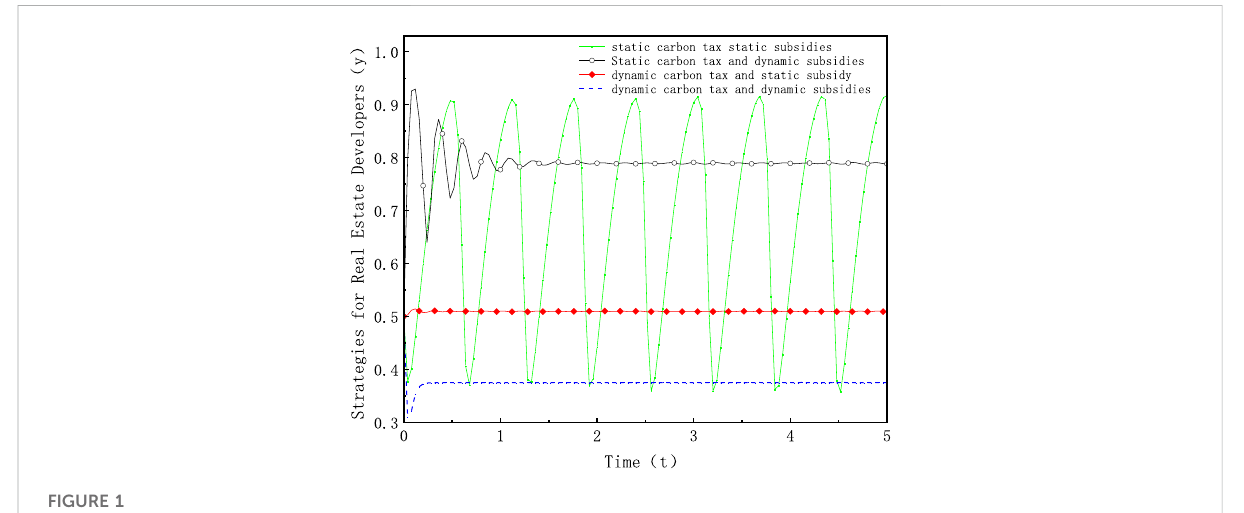
FIGURE 1 The strategy evolution process of property developers.